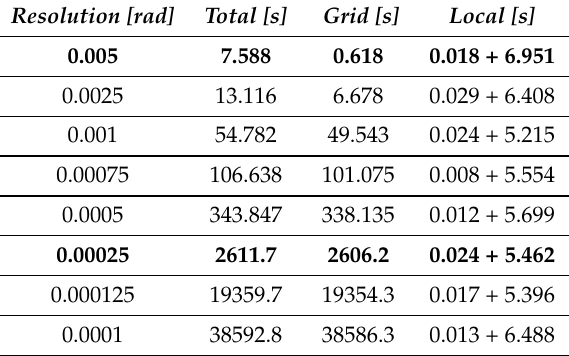
Table 1. Logged durations of the single optimisation steps with grid resolution in the first column. The second column shows the total durations composed from the time taken by the grid search (third column) and the subsequent local optimiser for the orientation and translation (last column). The resolutions used in experiments are